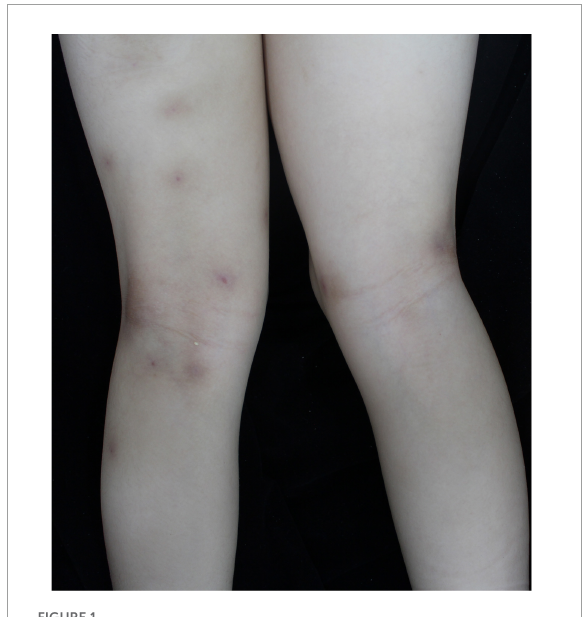
FIGURE1 Multiple dull red plaques were observed on the lower limbs.